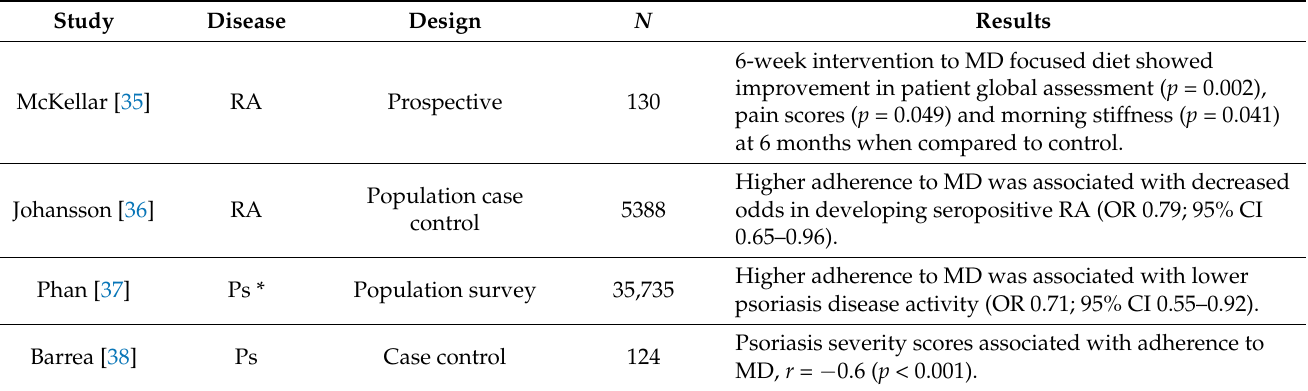
Table 1. Summary of the Mediterranean diet (MD) studies in rheumatoid arthritis and psoriasis with potential applicability to irritable bowel disease (IBD). Collective data show adherence to an MD may reduce clinical disease activity in inflammatory diseases. Based on this and growing evidence in IBD, it is reasonable to consider recommending an MD in patients with IBD, but clearly, this warrants further